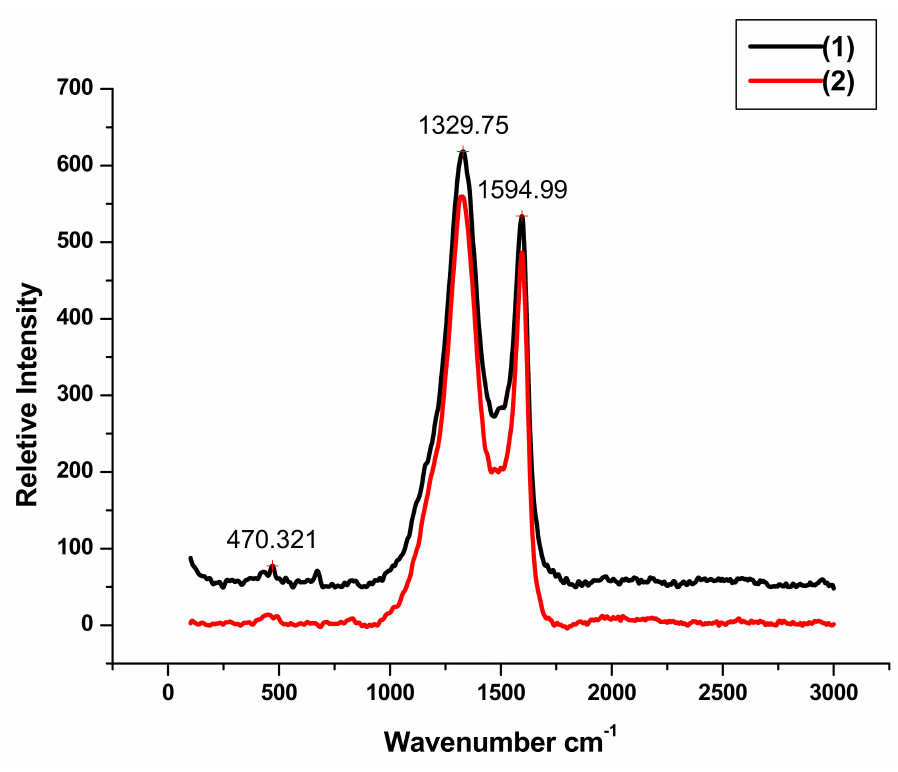
Figure 3. Raman spectra of (1) and